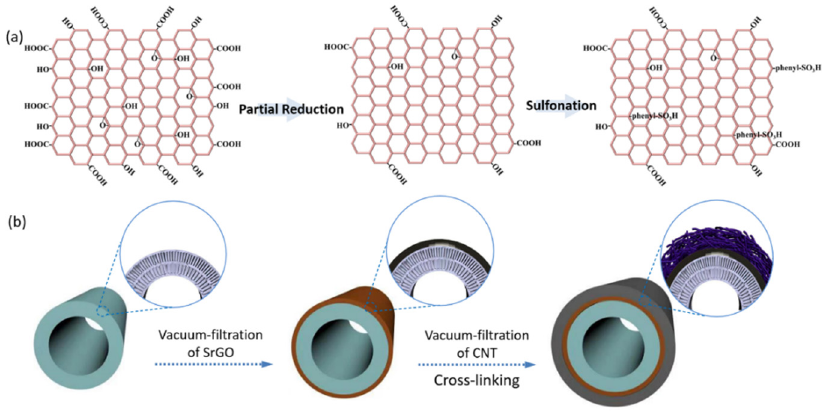
Figure 1. ( a ) Schematic illustration for the structures of GO, partially reduced GO and SrGO; ( b ) Schematic illustration for the preparation of SrGO membranes.